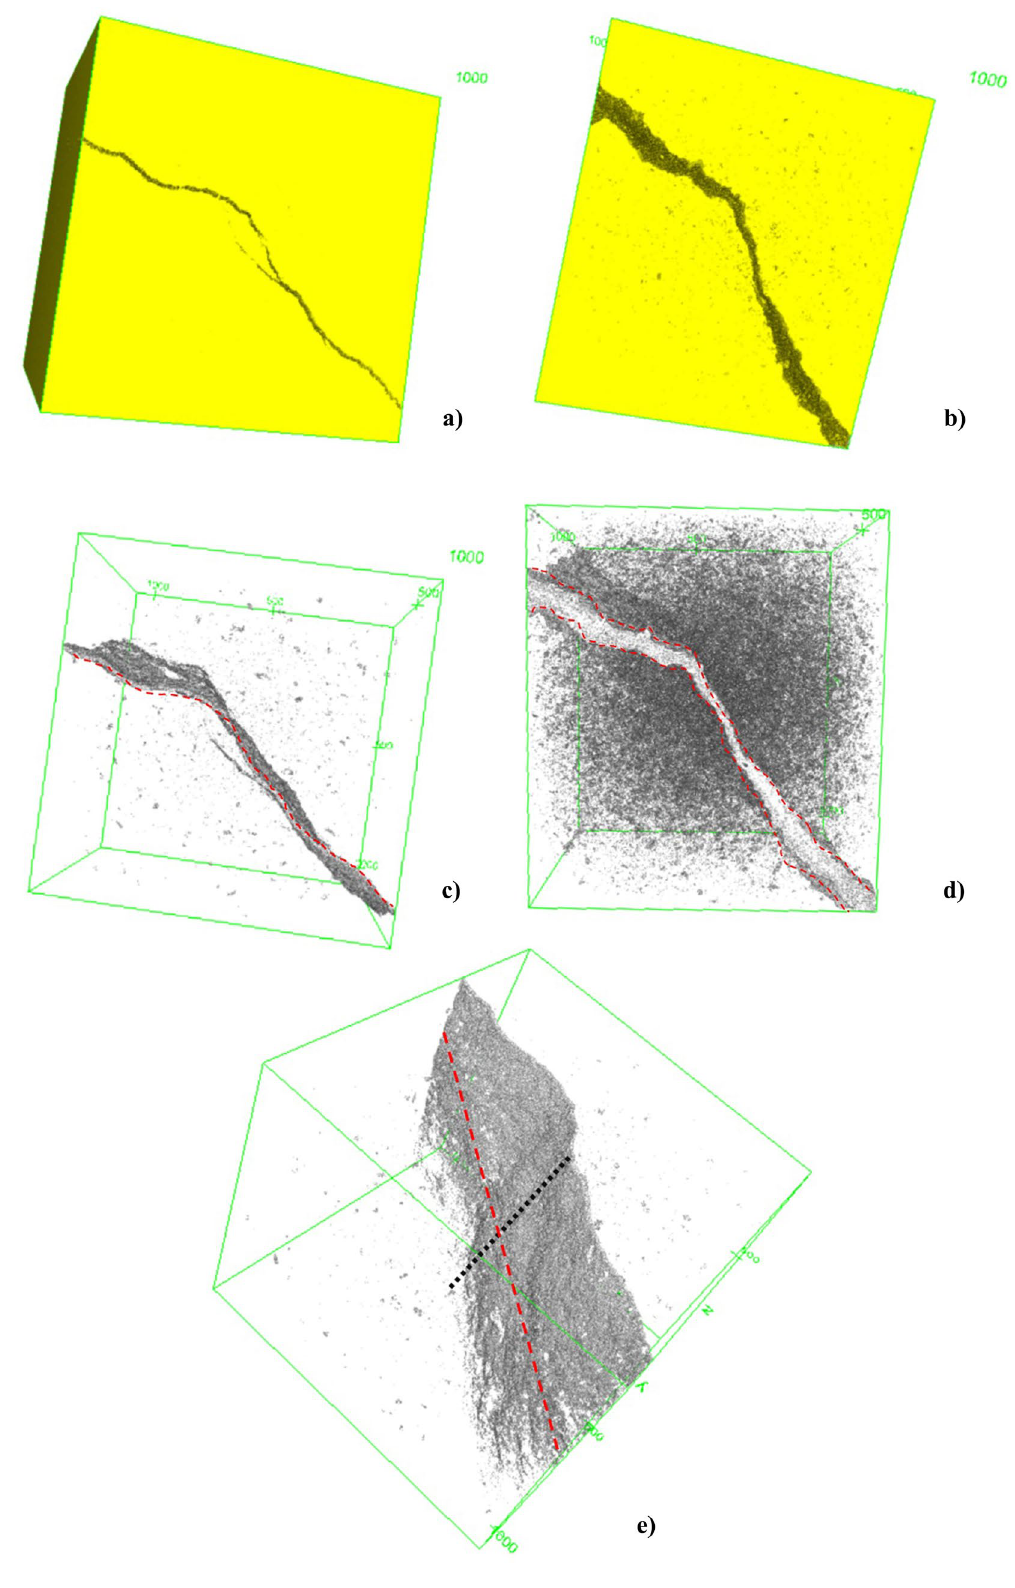
Figure 23. A 3D structure of the solid matrix of the fractured sample ( a ) before degradation and ( b ) after degradation. Comparison of pore arrangement and fracture opening of the specimen ( c ) before and ( d ) after degradation. (e) Fracture length and depth along the specimen represented by the red dashed and black dashed lines,